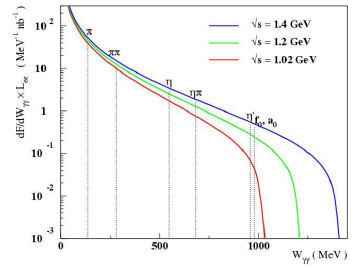
Figure 1: E ff ective luminosity for γγ processes at three di ff erent energies.